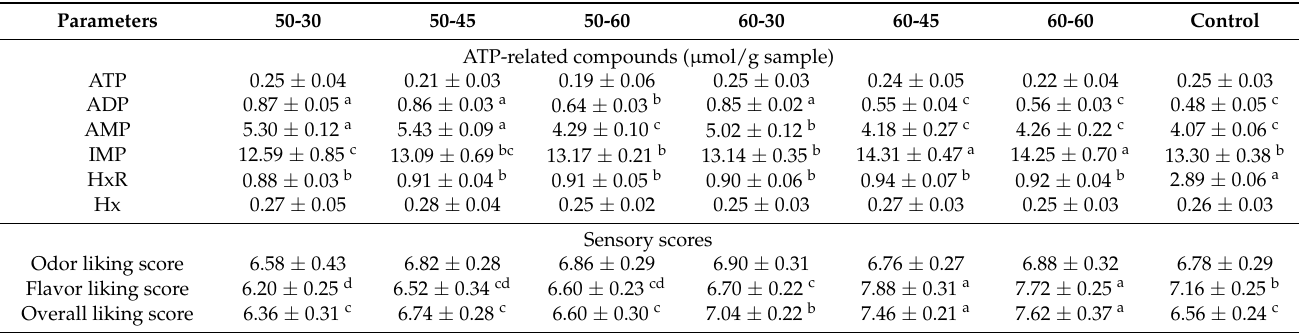
Table 3. ATP-related compounds and sensory scores of SV-cooked tilapia processed by various SV